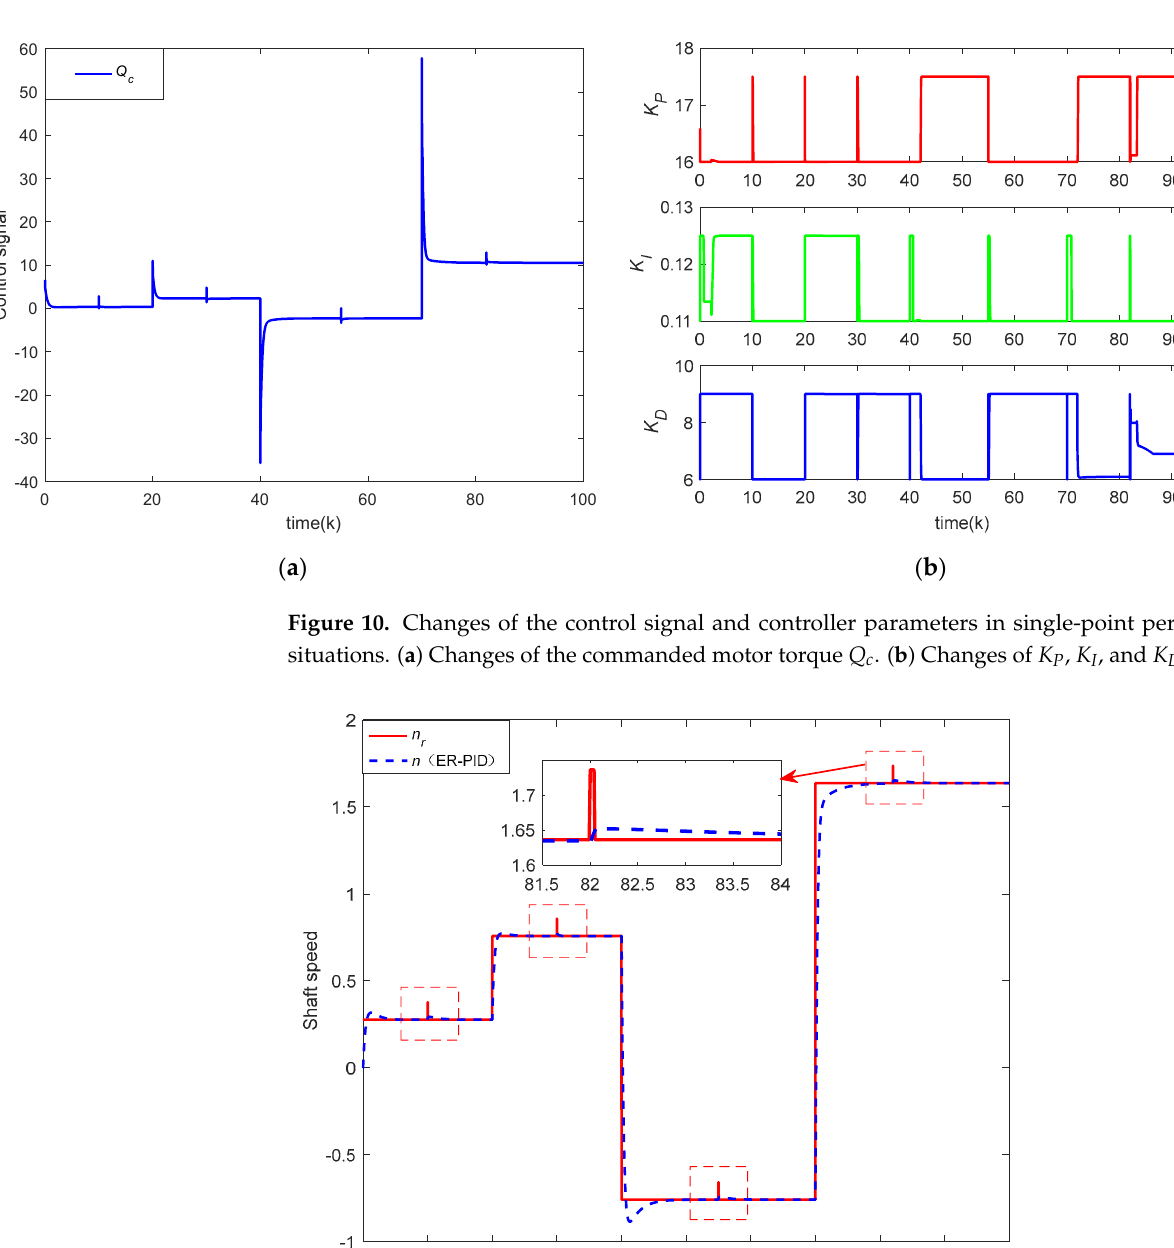
Figure 9. Tracking results of the ER ‐ PID controller with a single ‐ point perturbation.